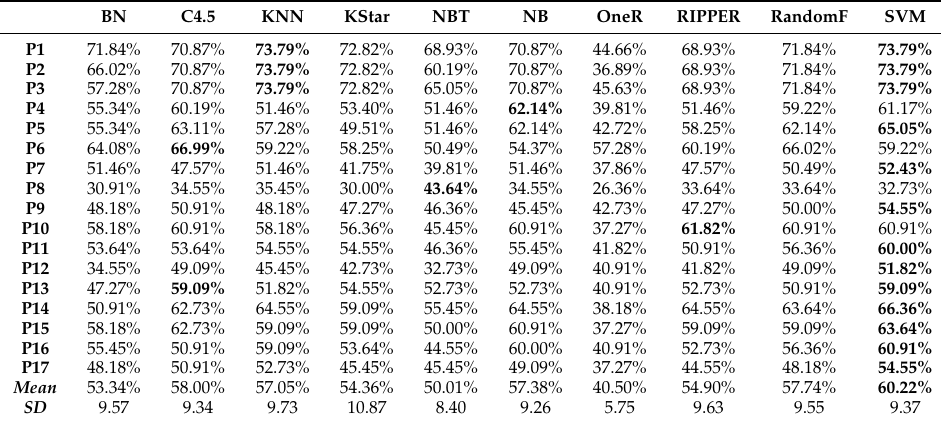
Table 4. First phase. Accuracy percentages for each person applying CSS stacking with the EDA classification method. Mean and SD rows denote the average and standard deviation for each classifier working as meta classifiers and considering all of the actors.